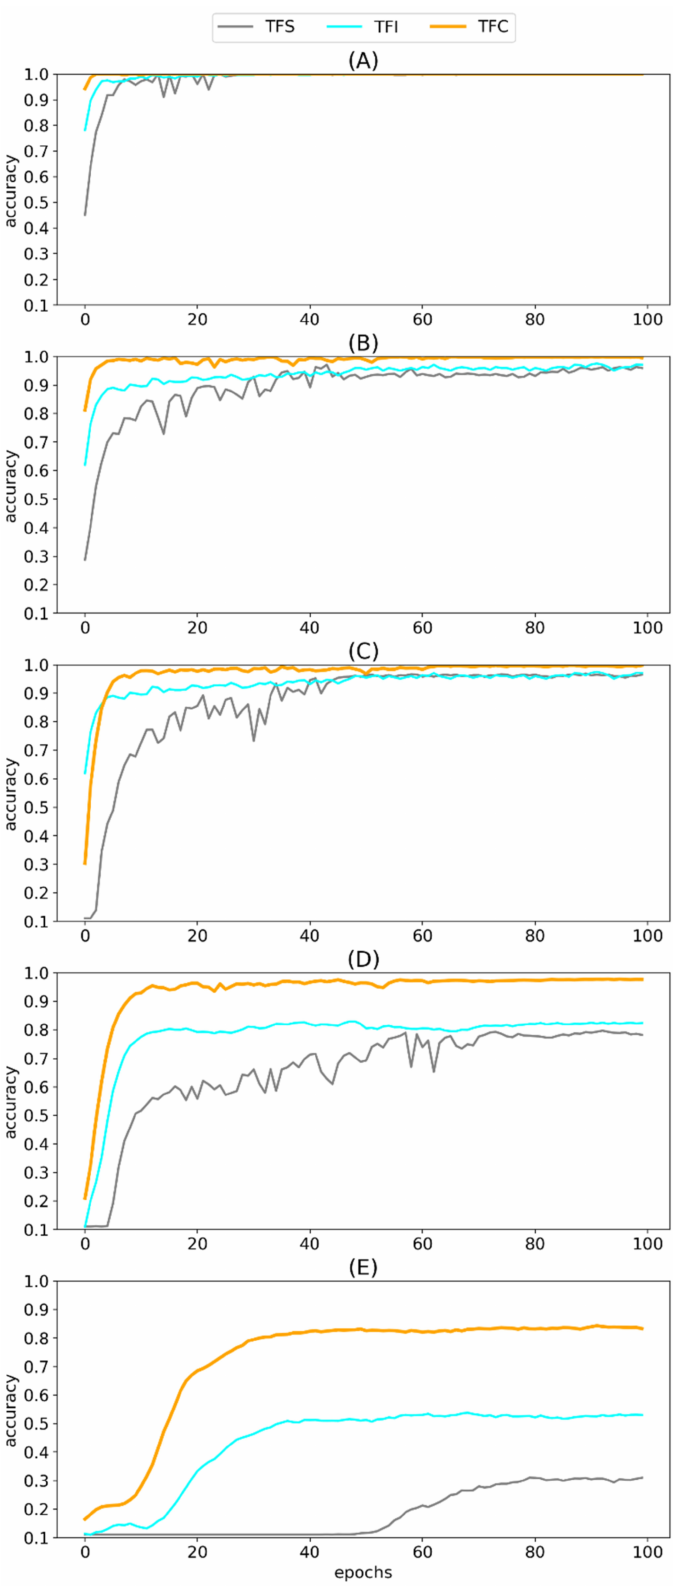
Figure 8. Training history of the three learning schemes in our target task, under various splitting ratios: ( A ) 90:10; ( B ) 50:50; ( C ) 10:90; ( D ) 5:95; ( E )